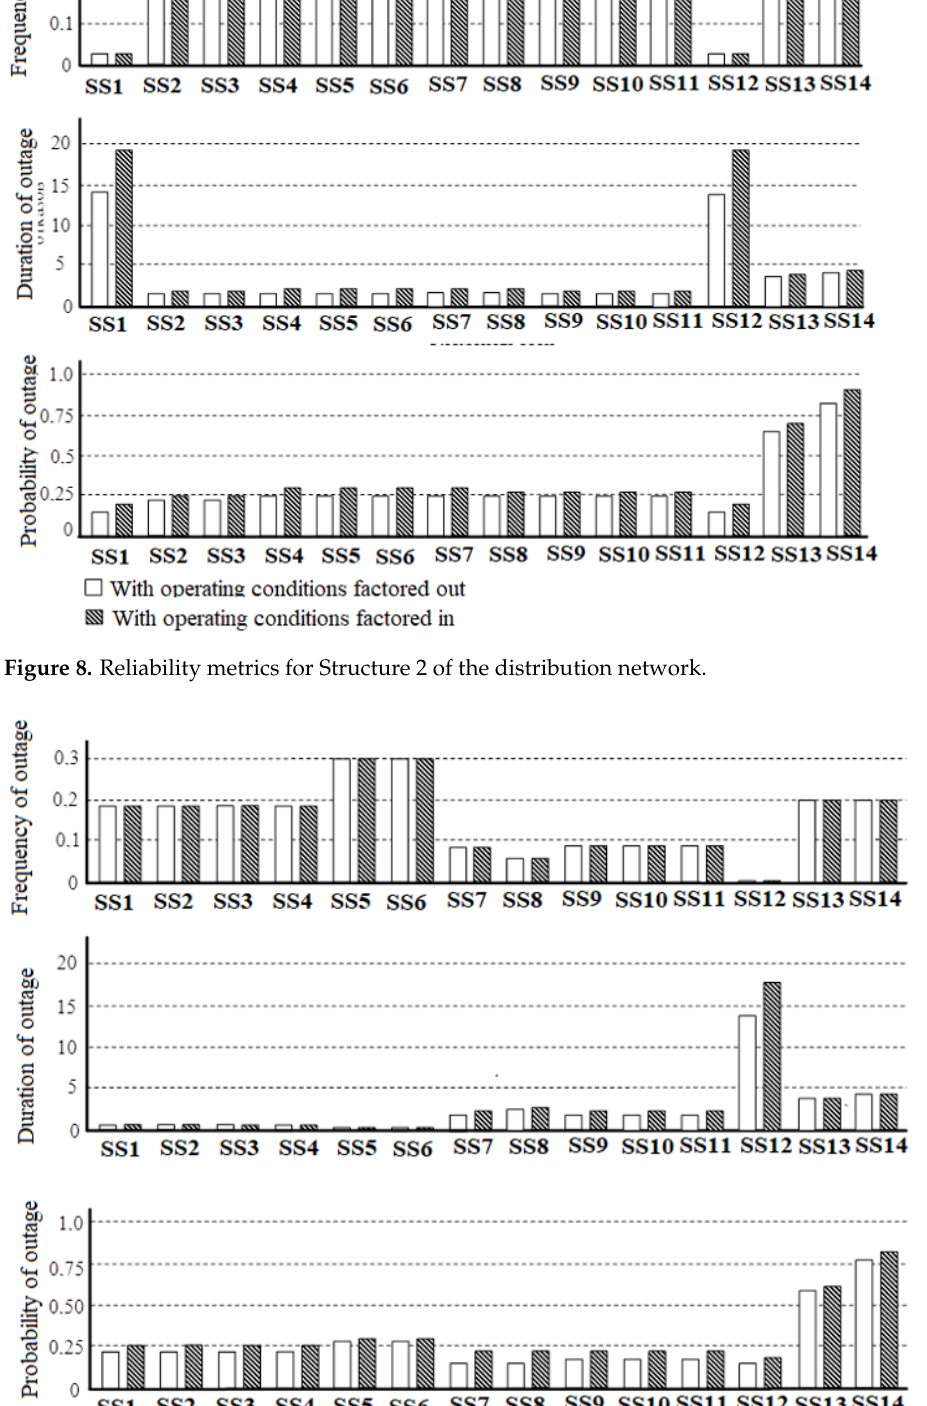
Figure 9. Reliability metrics for Structure 3 of the distribution network.